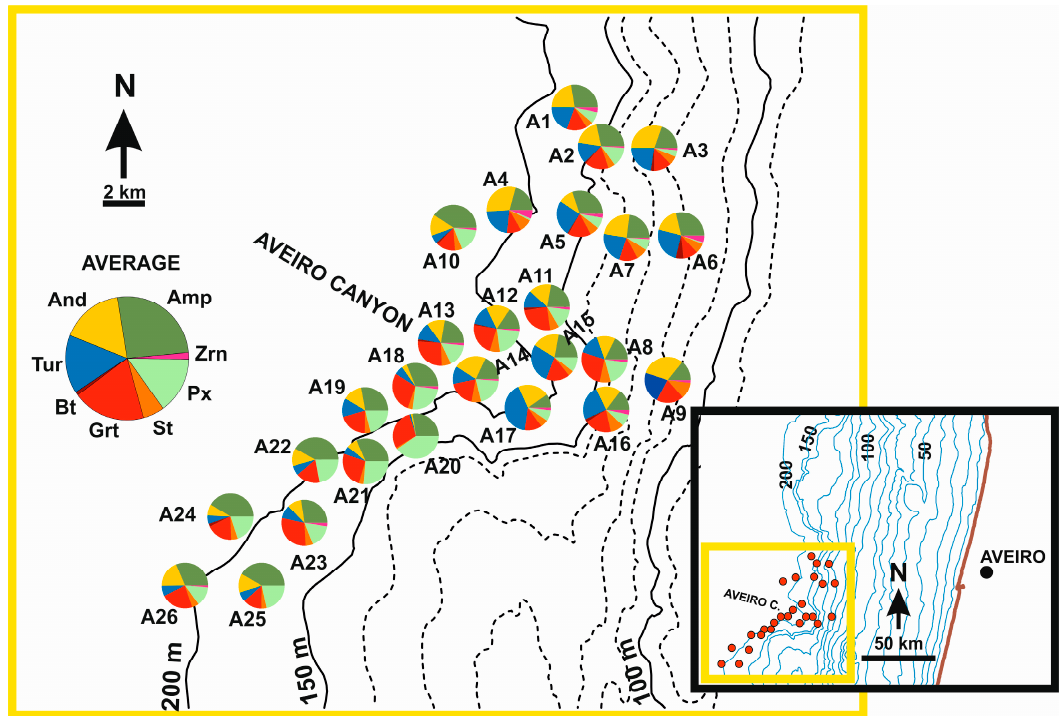
Figure 6. Main heavy mineral suite distribution according to the samples collected from the Aveiro upper canyon area. The average values are represented on the larger pie chart.